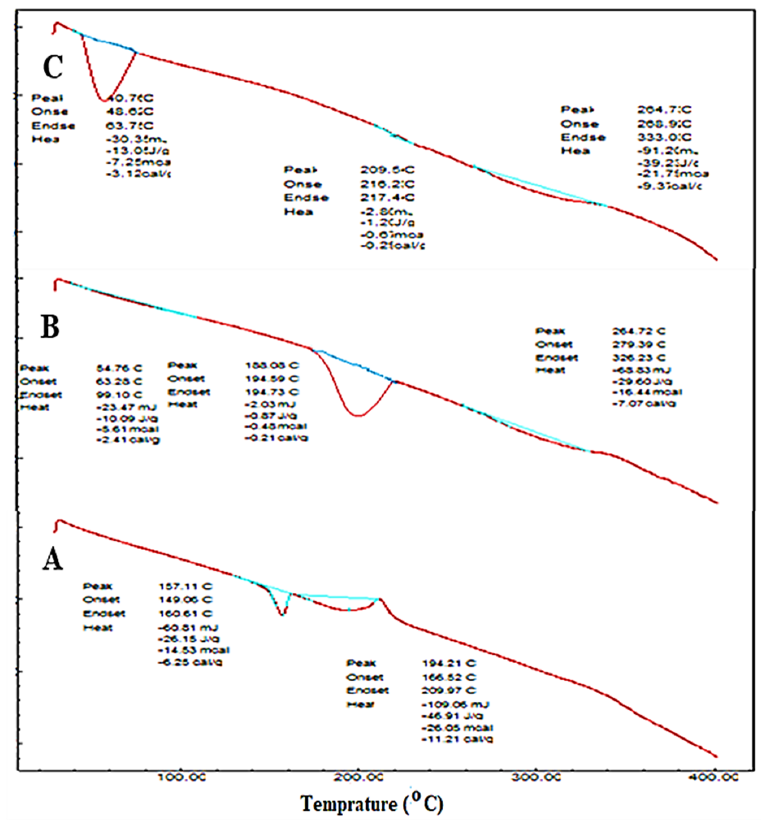
Figure 6. Thermal transition analysis of ( A ) pure EZL, ( B ) maltodextrin and ( C ) EZL ‐ PNsopt. Molecules 2022 , 27 , x FOR PEER REVIEW